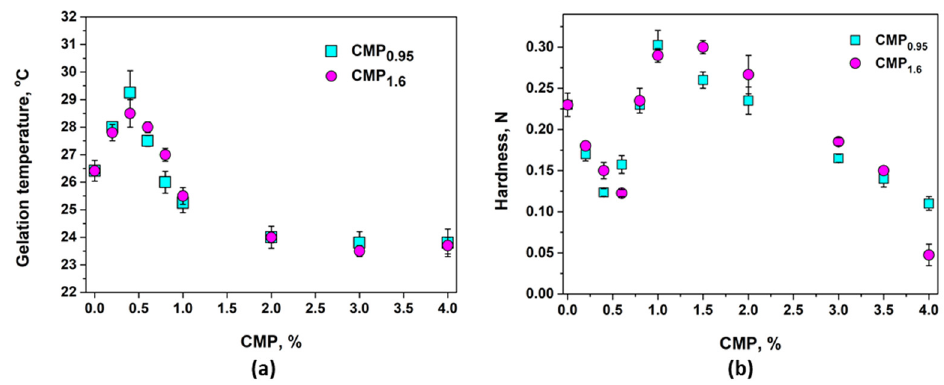
Figure 5. Variation in the gelation temperature (determined by test inversion method) ( a ) and of the gel hardness (texture analysis method) ( b ) of 17% PL solution with the addition of CMP in different concentrations.